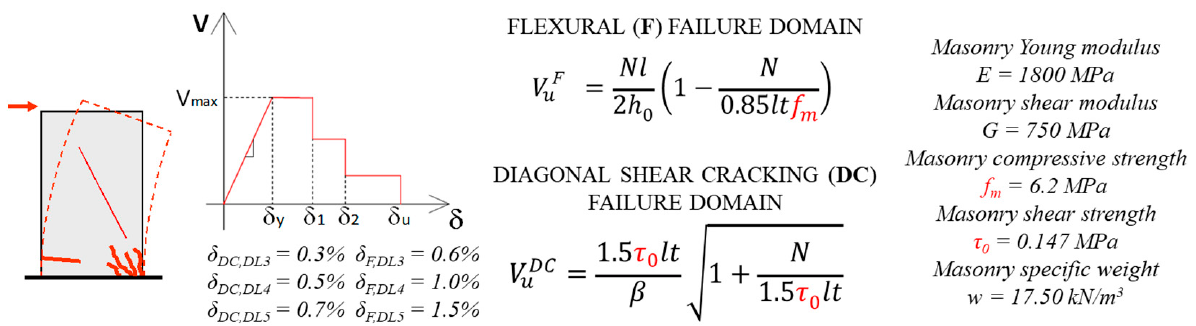
Figure 4. Strength criteria were adopted as “target strength behavior” for the calibration process (adapted from [8]).